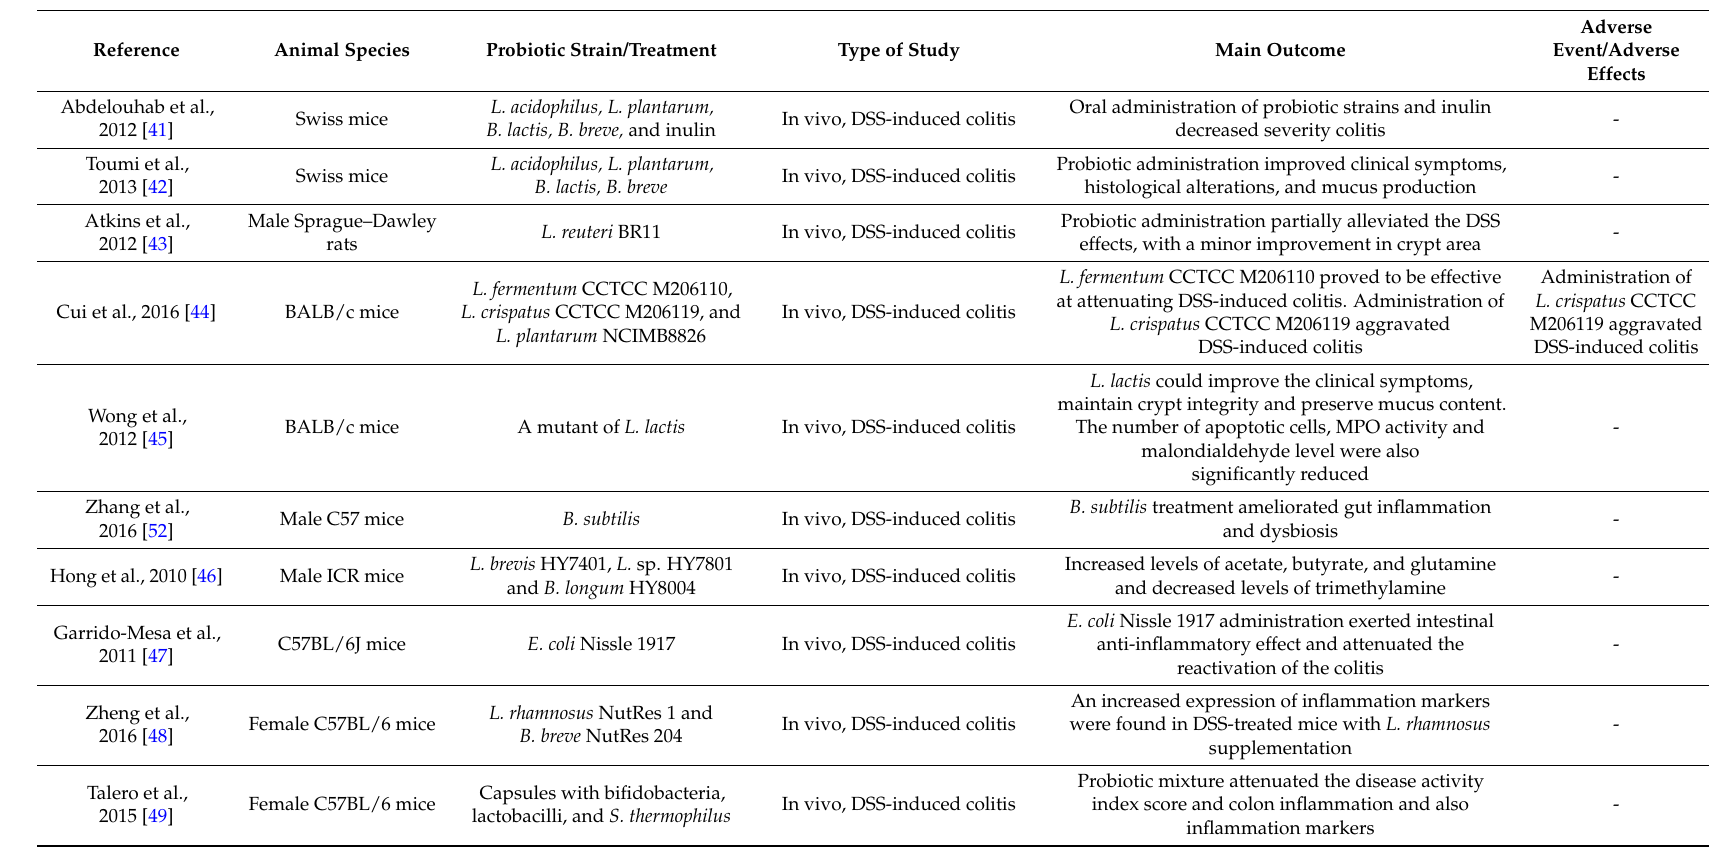
Table 2. Summary of probiotic anti-inflammatory effects in animal